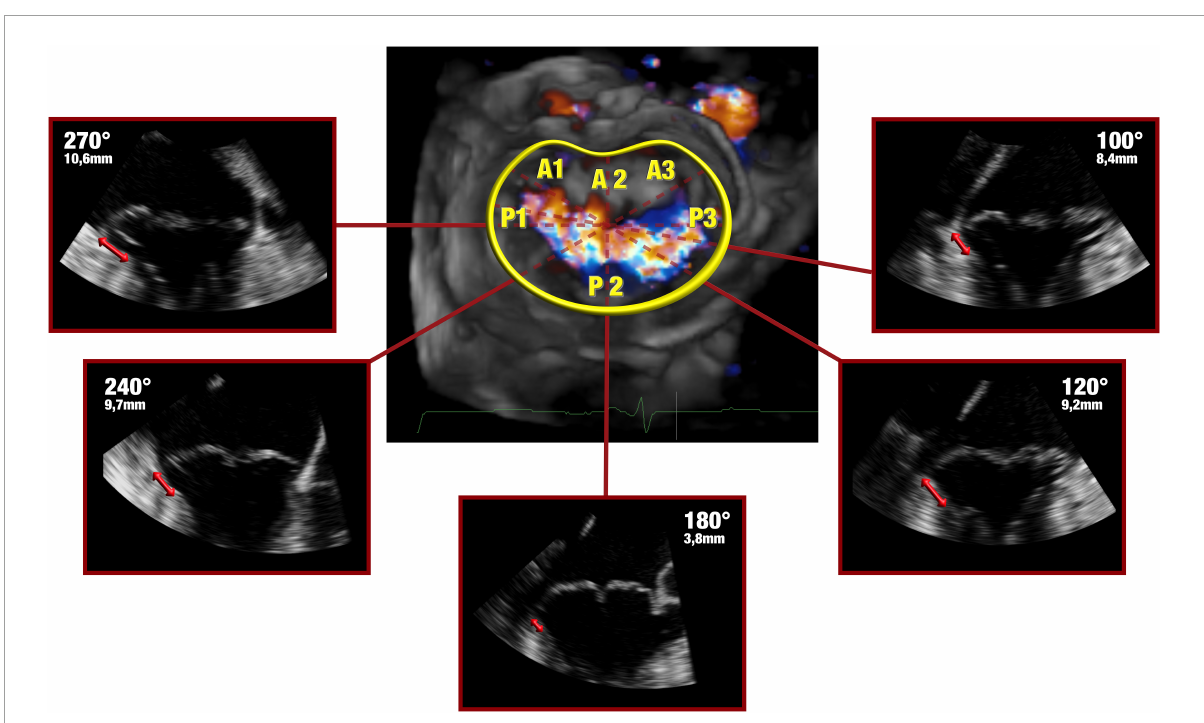
FIGURE1 Late systolic frames of the digitally stored datasets were analyzed offline. The 3-dimensional anatomy of MAD was assessed by rotating a plane orthogonal to the ideal annular plane at 10 ◦ intervals, as already described by Lee et al. (4). Bidirectional red arrows highlight the extent of the disjuncted